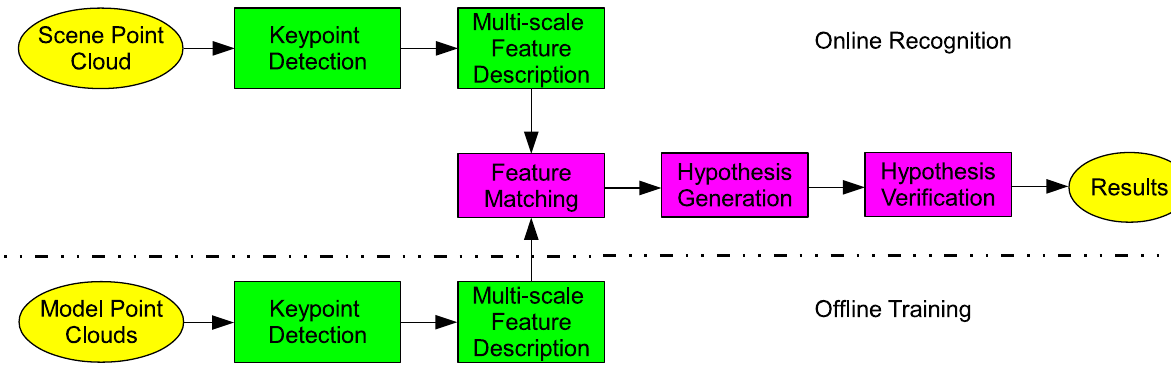
Figure 3. The pipeline of the 3D object recognition algorithm (figure best seen in